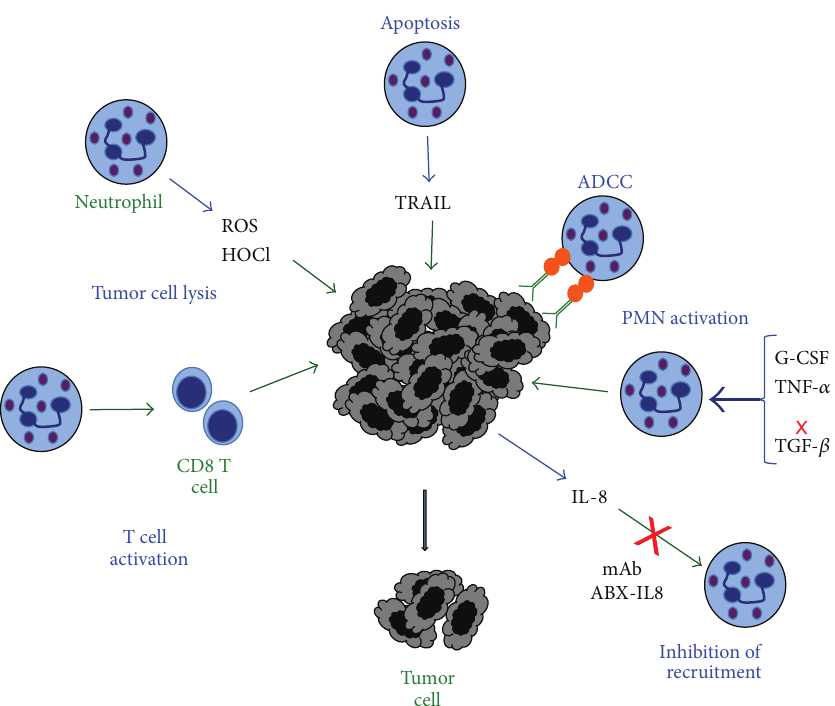
Figure 4: Antitumor activity of neutrophils. Neutrophils produce reactive oxygen species (ROS) and hypochlorous acid (HOCl) that can directly damage and destroy tumor cells. By direct contact or by release of TRAIL, neutrophils can also induce apoptosis of certain tumor cells. The most effective antitumor mechanism is antibody-dependent cell-mediated cytotoxicity (ADCC). Antibody molecules (green) that bind to tumor antigens are recognized by Fc receptors (orange circles) on neutrophils. This binding activates a cytotoxic response against the tumor cell. Neutrophils can be activated to display a stronger antitumor phenotype with granulocyte colony-stimulating factor (G- CSF), transforming growth factor- 𝛼 (TNF- 𝛼 ), or by blocking (red cross) transforming growth factor- 𝛽 (TGF- 𝛽 ). Also, the blockage of IL-8, with specific monoclonal antibodies (such as mAb ABX-IL8), can prevent new neutrophil infiltration into growing tumors. Inflammatory neutrophils can also activate cytotoxic (CD8) T cells. All these mechanisms result in smaller tumors. Blue arrows denote molecules secreted by cells. Green arrows denote the action of molecules on